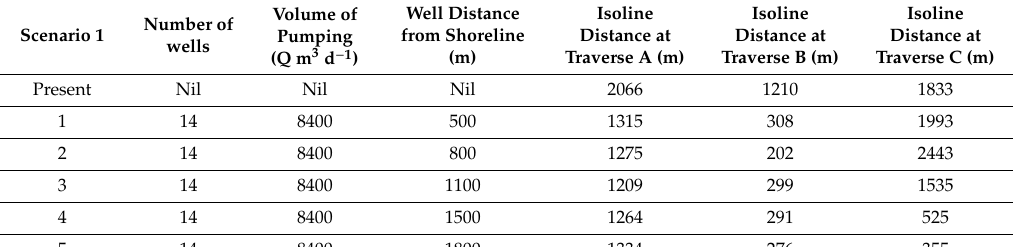
Table 3. Distance of 15,000 mg L − 1 Isosalinity Contour along Traverse A, B and C after Constant